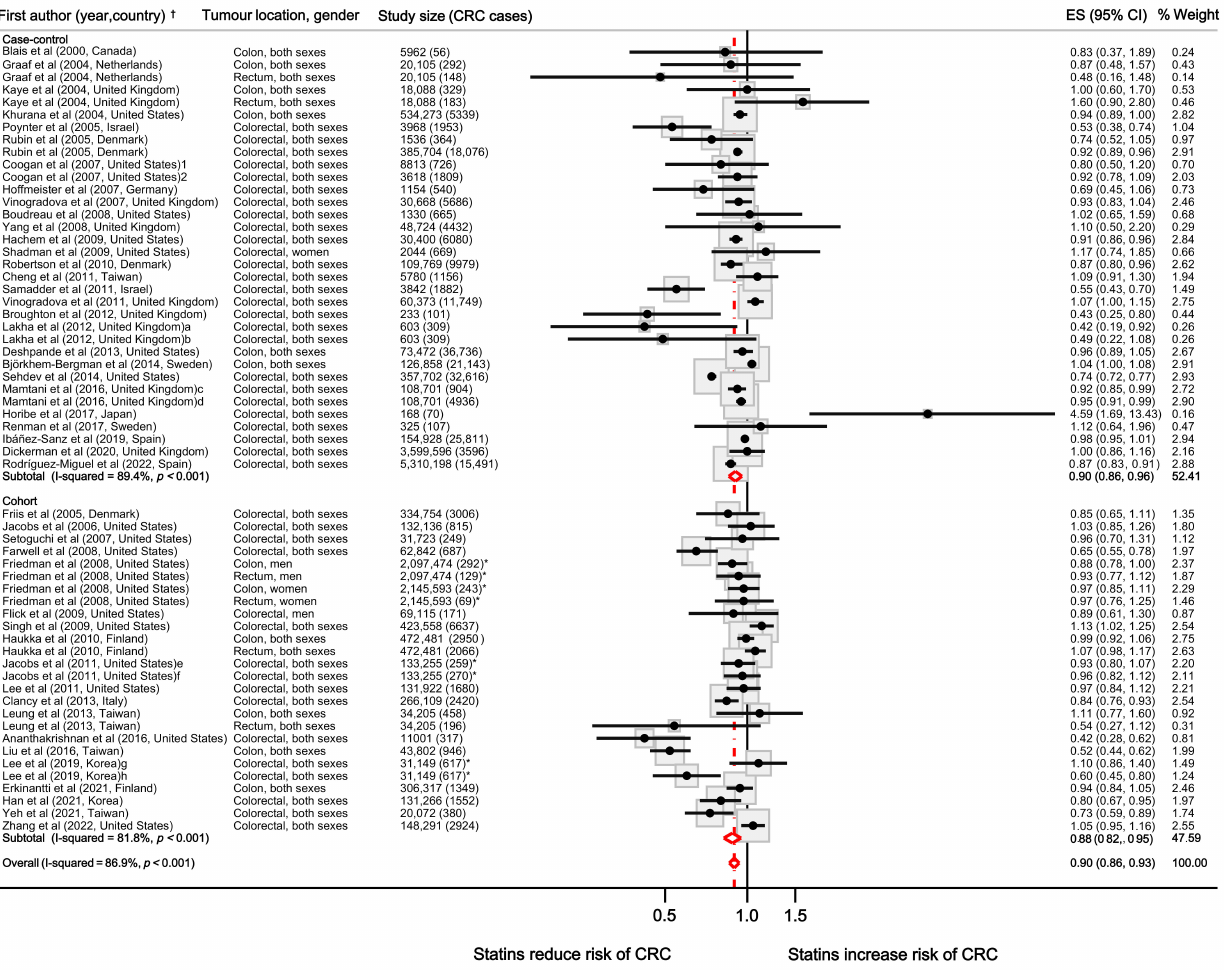
Figure 3. Forest plot. Results from individual studies and pooled estimates from random-effects model. CRC: colorectal cancer; ES: effect size in the multiplicative scale from pooled odds ratios, relative